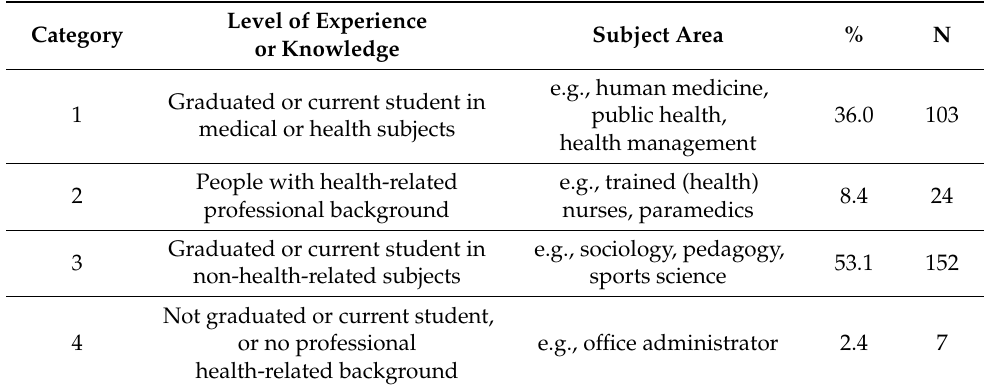
Table 1. Profession backgrounds of the Containment Scouts (first